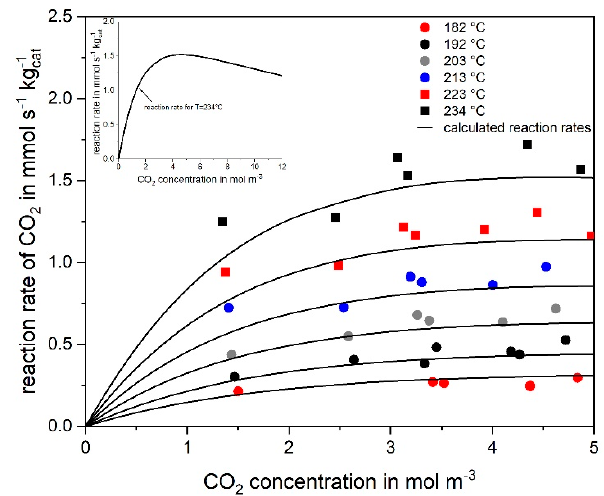
Figure 3. Rate of reaction of CO 2 with H 2 (to CH 4 ) at different initial CO 2 concentration at different temperatures (marks) compared to calculations based on Equation (6) (solid lines) (55 vol% H 2 , rest N 2 , m cat = 2 g, p = 1 bar).